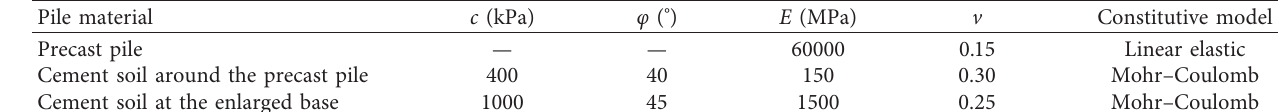
Table 4: Parameters of the precast pile and cement soil.